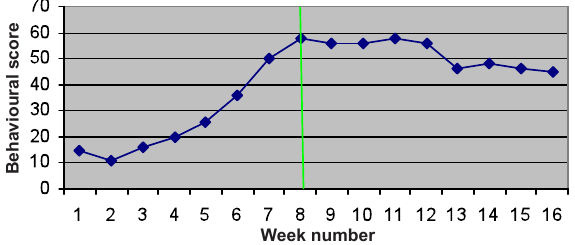
Figure 5. Behavioural scores of V . The weeks which show Figure 4. Behavioural scores of V . The weeks which show 2 1 the highest score for V are between the 8 th and 12 th weeks. the highest score for V are between the 7 th and 11 th weeks. 2 1 This is a longer duration than that observed for V3. In This is equal in duration as observed for V2, but it onsets its case the velvet was shed during the 8 th week (vertical early. In this case the velvet was shed during the 7 th week green line). The behavioural score was 24.85±13.83 during (vertical green line). The behavioural score of stag V was 1 the velvet phase. As it shifted to the hard antler stage, the 23.16±12.84 during the velvet stage, but as it entered the score increased to 51.9±5.38. rut season, its score shot up to 51.81±5.54.